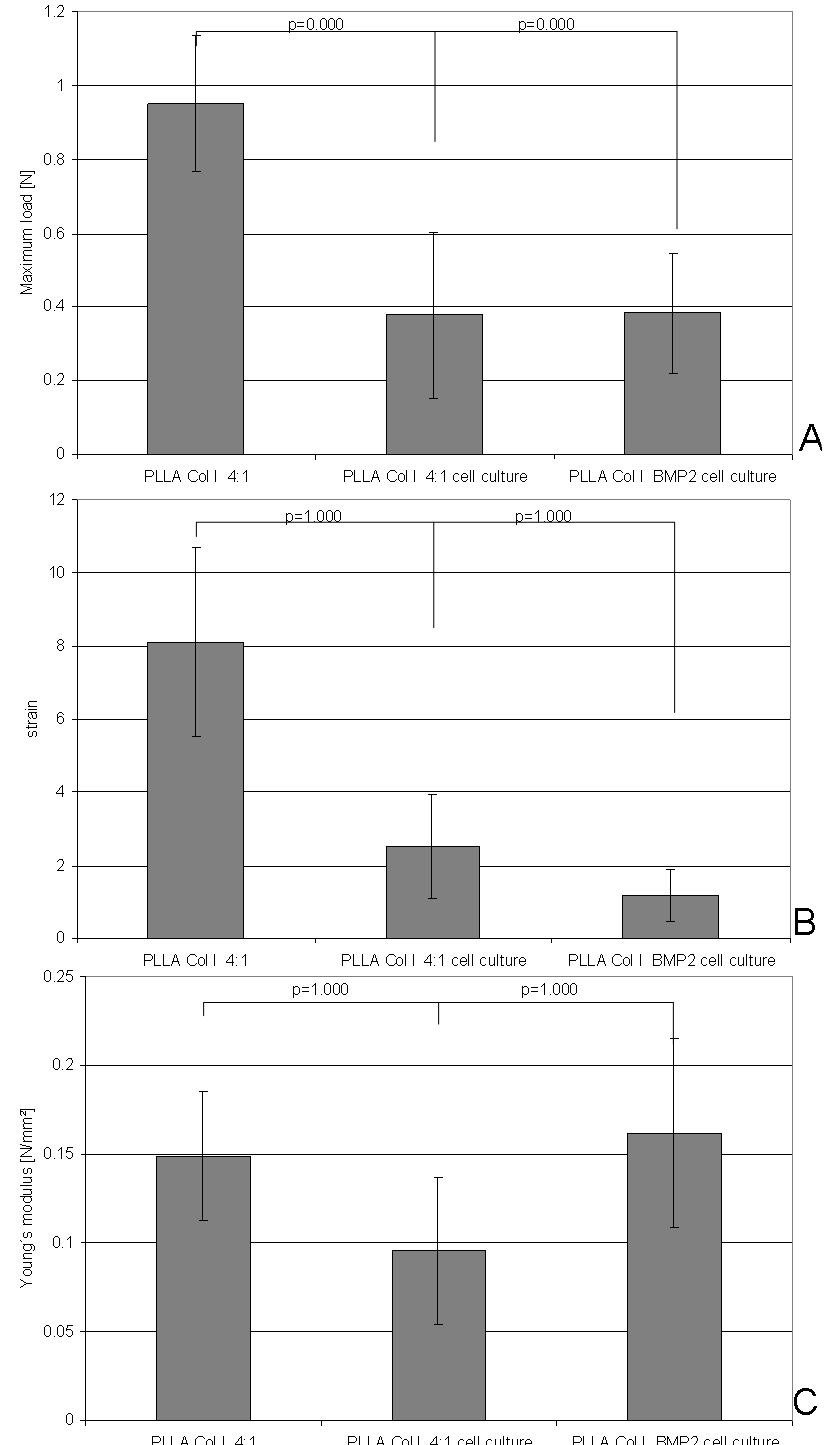
FIGURE 5. Influence of cells on PLLA-collagen blend nanofibers on maximum load (A), strain (B), and Young’s modulus